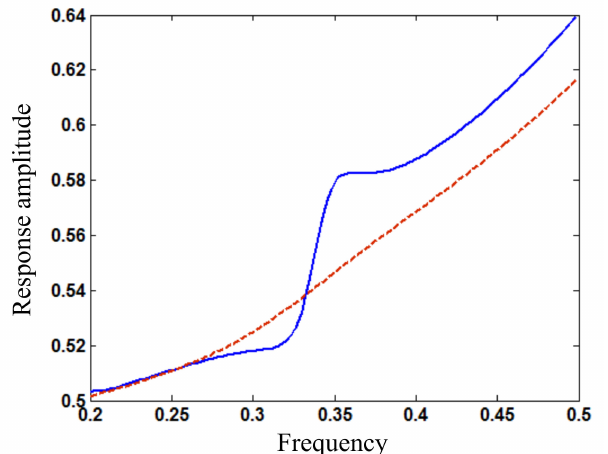
Figure 13. Amplitude ( w Am ) frequency ( ω ) relation around super-harmonic resonance for loading amplitude F s 1 = 0.5 and different damping coefficients c (blue solid line: c = 0.1; red dashed line: c =